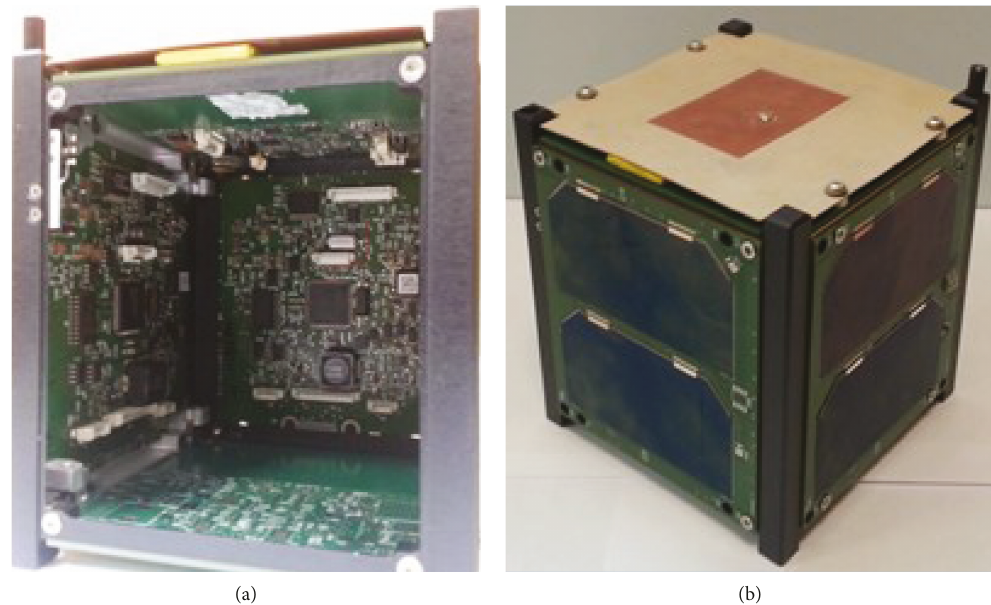
Figure 7: Photograph of AraMiS-C1 with 4 CubePMT and 2 CubeTCT tiles.